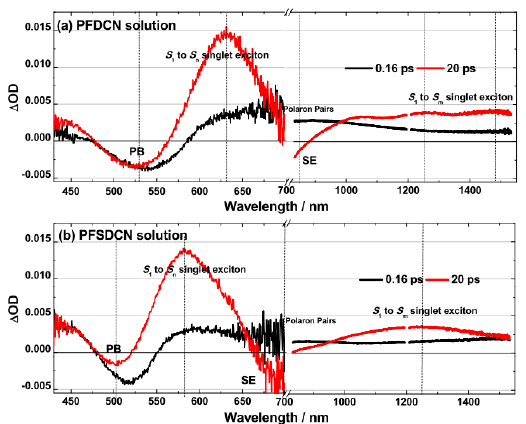
Figure 10. Comparison of transient absorption spectra of PFDCN ( a ) and PFSDCN ( b ) at 0.16 ps and 20 ps delay time.